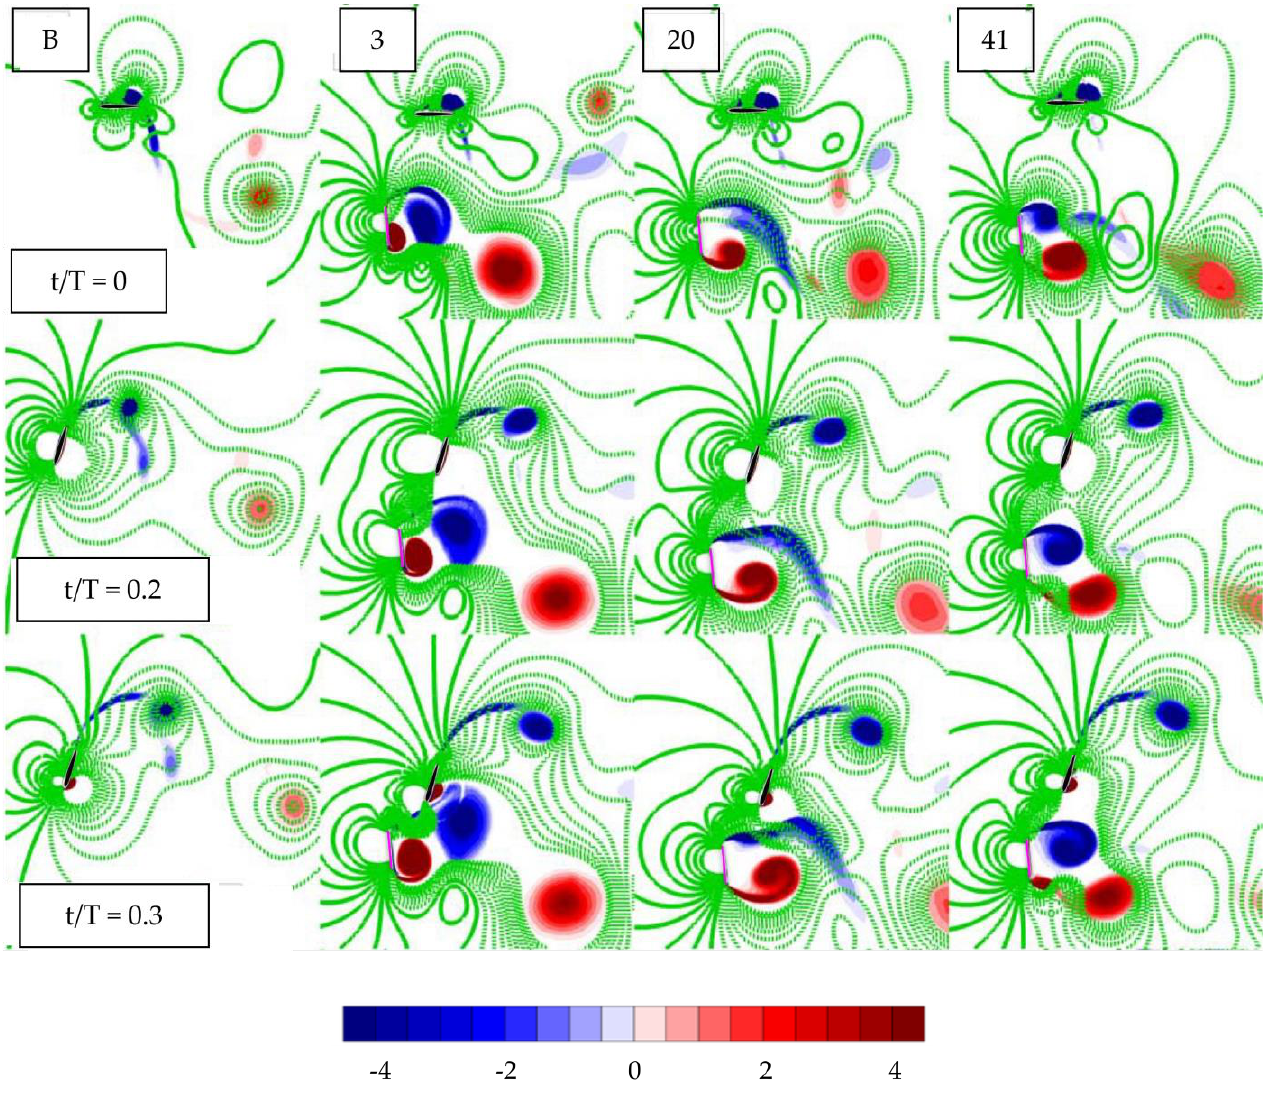
Figure 14. A comparison of the vortex structures and isolines of pressure of a hydrofoil with an upstream deflector at different deflector – hydrofoil spacings J * during downstroke (solid isolines: positive pressure; dashed isolines: negative pressure).